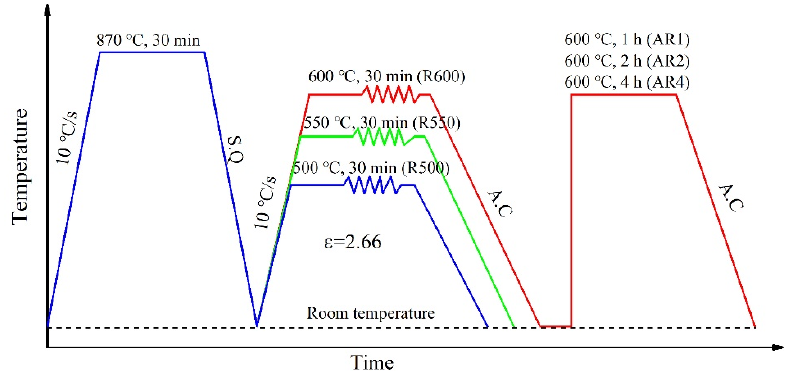
Figure 1. The pretreatment, warm rolling process, and heat treatment of the studied